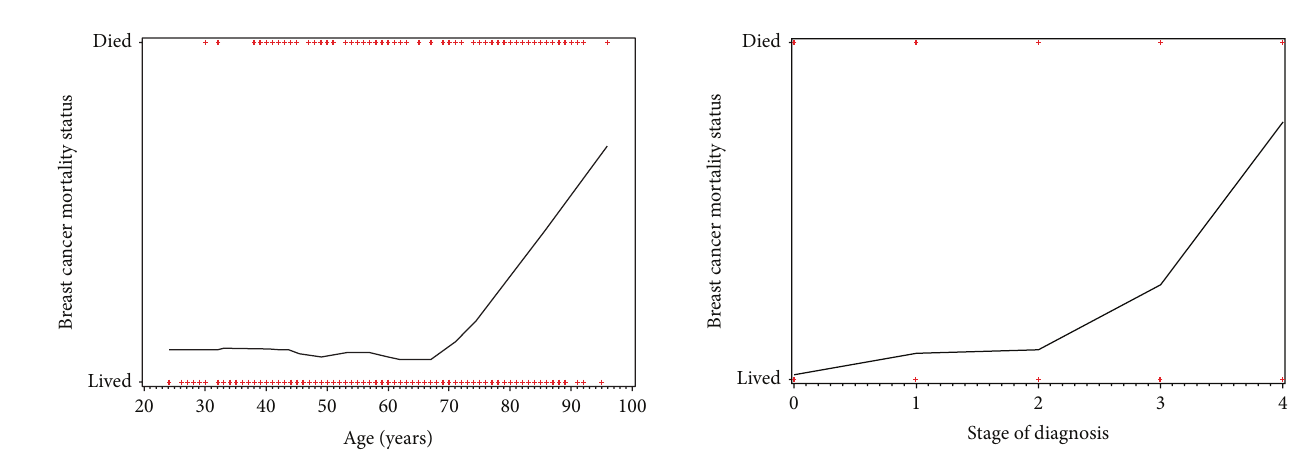
Figure 1: Breast cancer mortality by age shows significant increase in mortality rate after the age of 70 years.